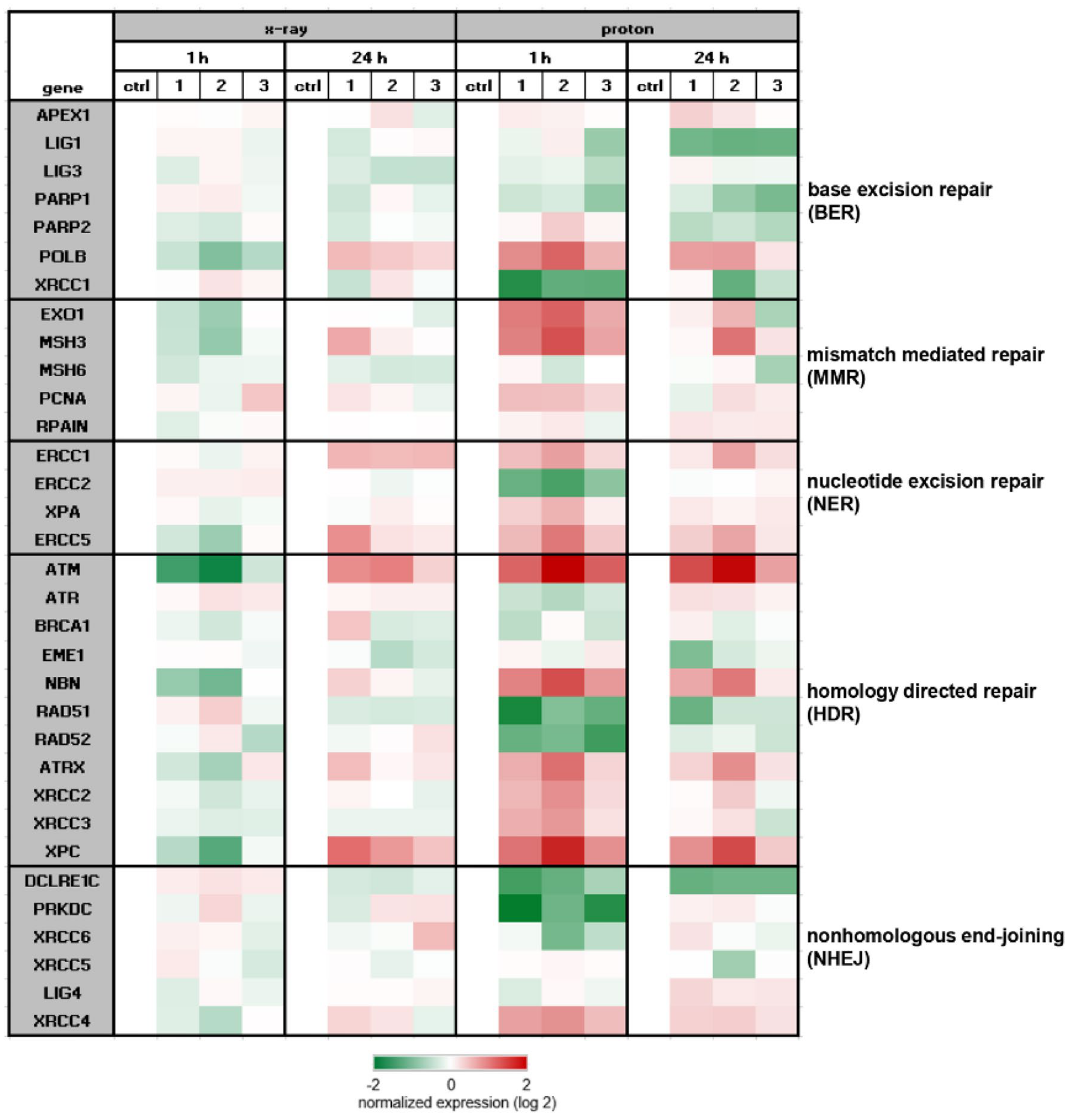
Figure 4. Next generation sequencing data. Heatmap blot of RNA sequencing data of the key players of DNA repair mechanism pathways presented in log2 fold change (n = 3) 1 h and 24 h after 6 Gy photon (X-ray; left) and 4 Gy proton IR